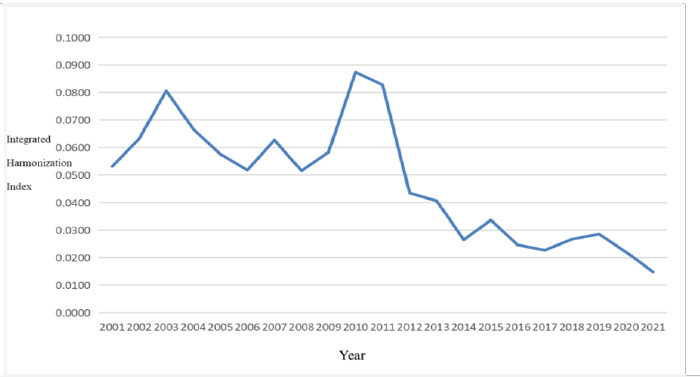
Figure 6. Visualization of comprehensive coordination index calculation results.